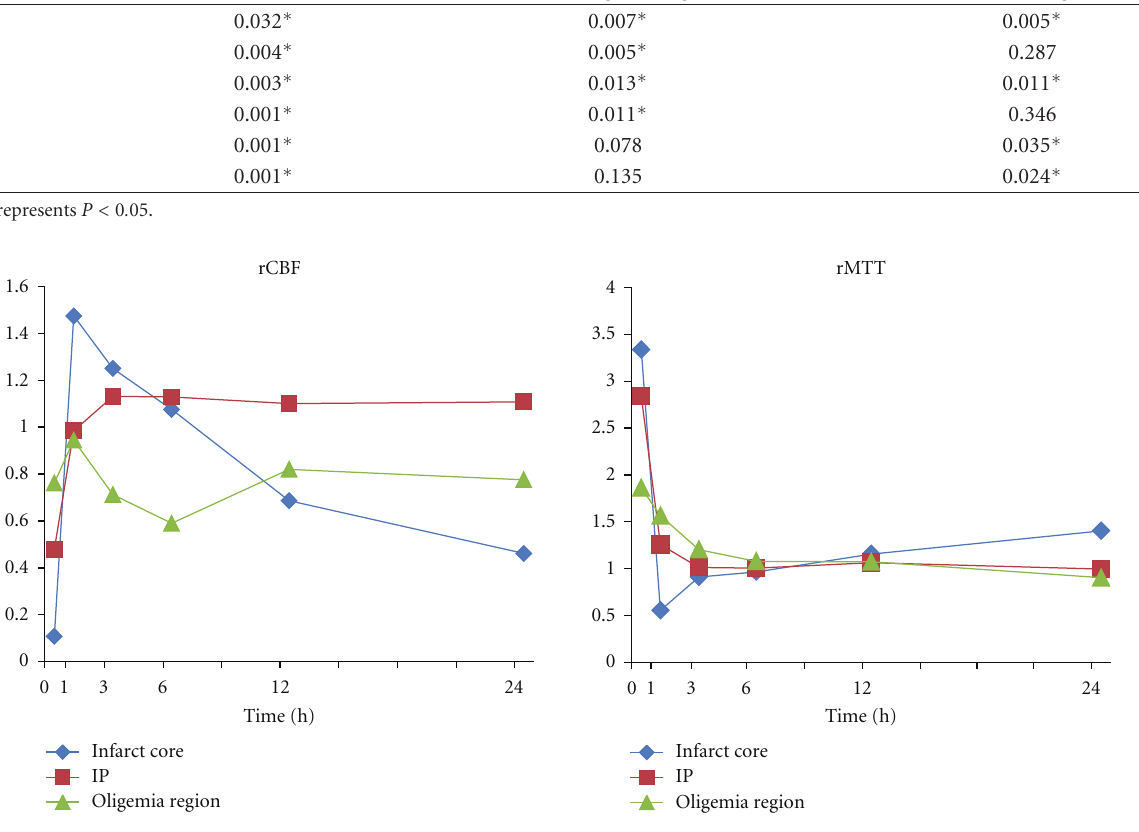
Figure 3: Evolution of rCBF and rMTT in di ff erent ischemic regions at the artery occlusion stage (0h) and reperfusion stage in the monkey MCAO